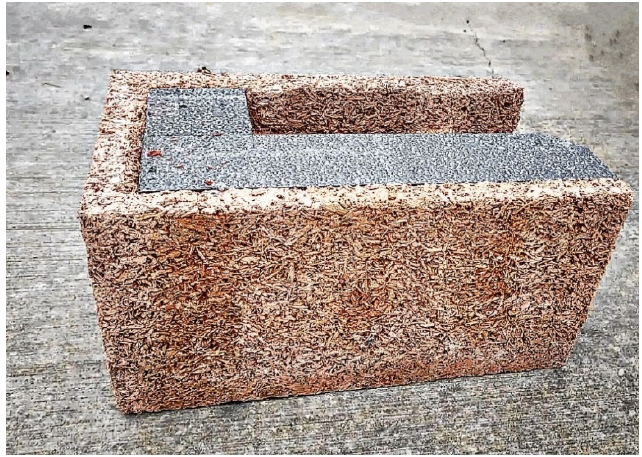
Figure 1. Concrete block with wood chips.